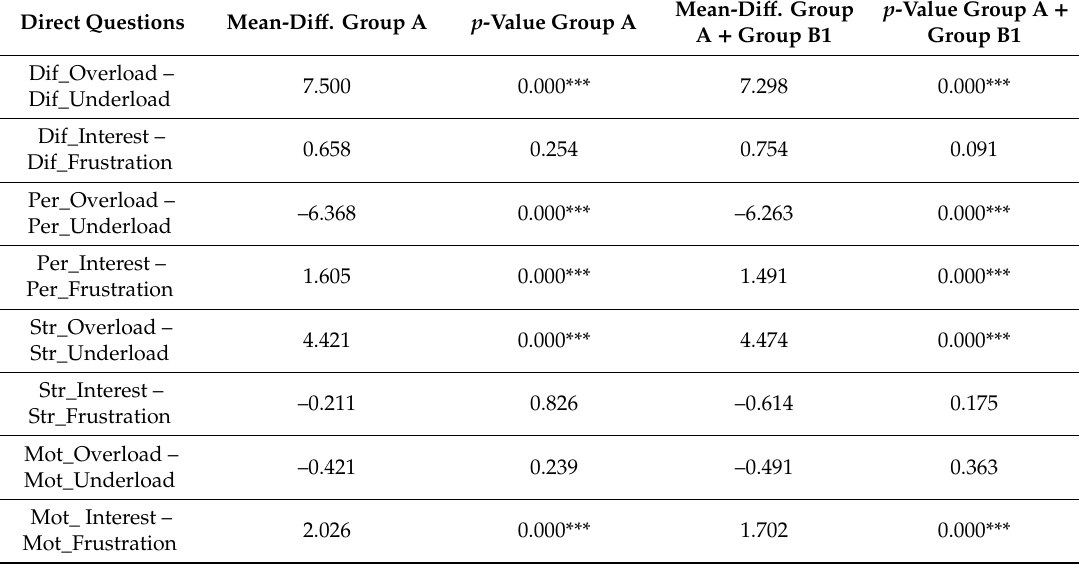
Table 6. Post-hoc Newman-Keuls corrections for the “Di ffi culty” (Dif), “Performance” (Per), “Stress” (Str) and “Motivation” (Mot) questions between Overload vs. Underload and Interest vs. Frustration . Mean-Di ff erences (Mean-Di ff .) and p- values are